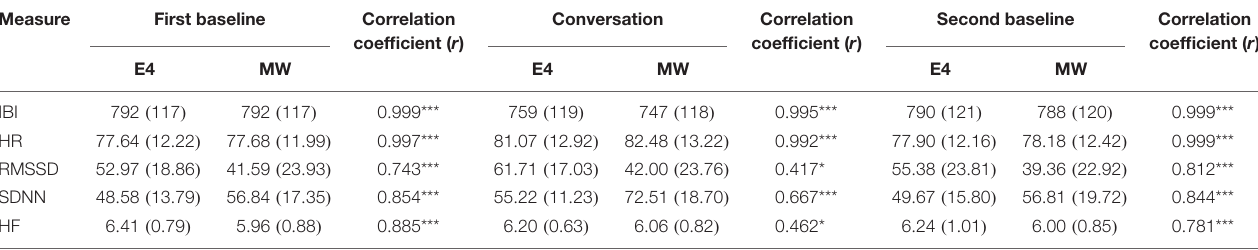
TABLE 2 | Mean (standard deviation) IBI, HR, RMSSD, SDNDD, and HF in each segment obtained by both the E4 and by the MW mobile device, and the correlation between the means obtained by the two devices. Measure First baseline